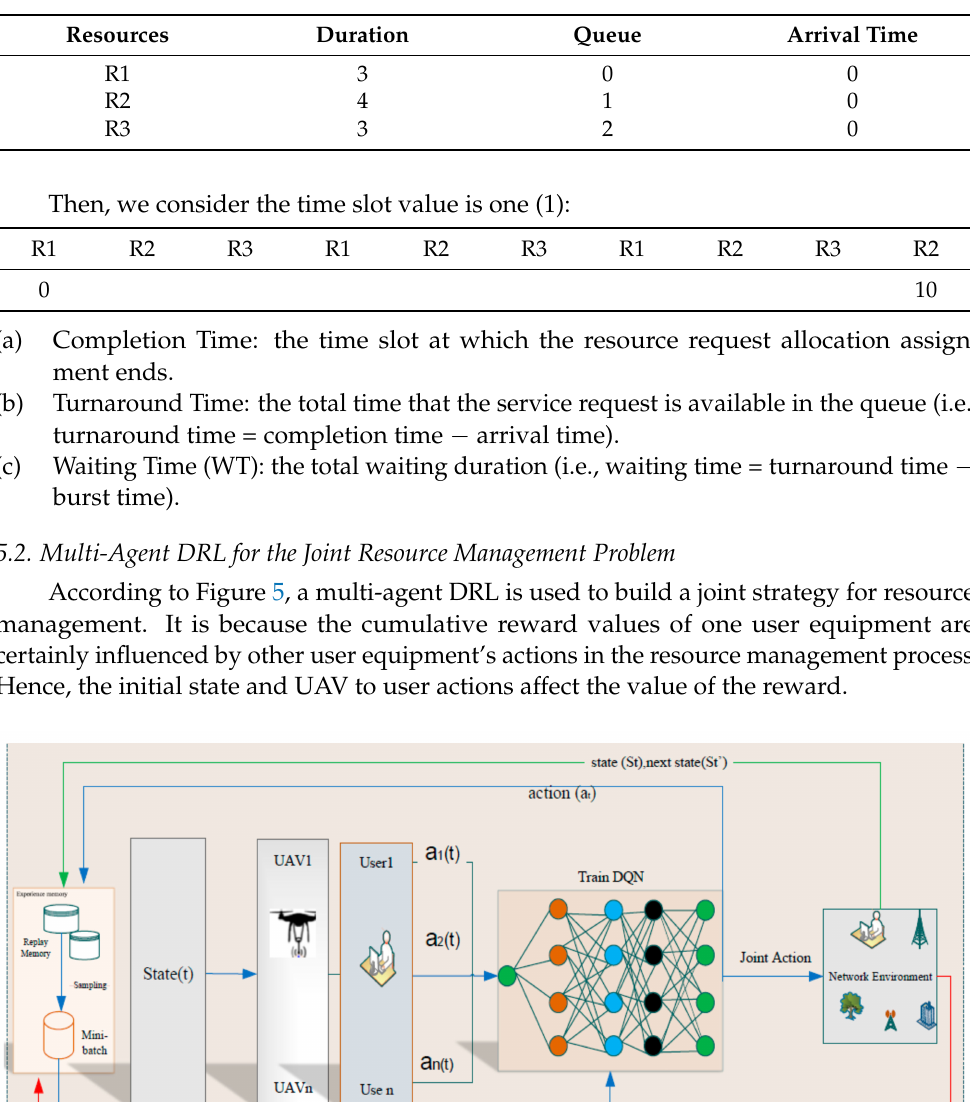
Table 3. Illustration of record of resources with a round robin scheduling-algorithm.